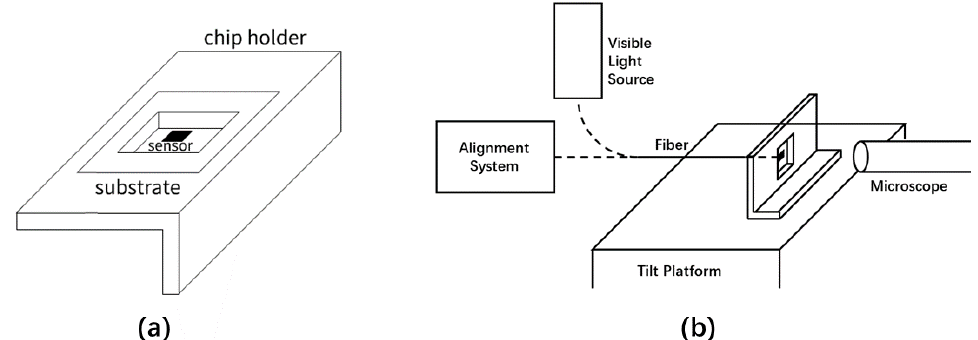
Figure 6. Alignment and verification with a dummy sensor on a transparent substrate [18]. ( a ) Dummy sensor fabricated on a substrate transparent to visible light and placed in a through-hole on a chip holder. ( b ) Setup to examine the position of the beam spot and compare it against that of the sensor by side-way observation from the backside of the sensor chip using an ordinary microscope under visible light. The fiber is connected to the alignment system in Figure 1a operating at 1310 nm during alignment. It is attached to an (unshown) 3-axis translation stage to adjust its position against the sensor chip. When the alignment is completed, the fiber is connected to a visible light source to verify the